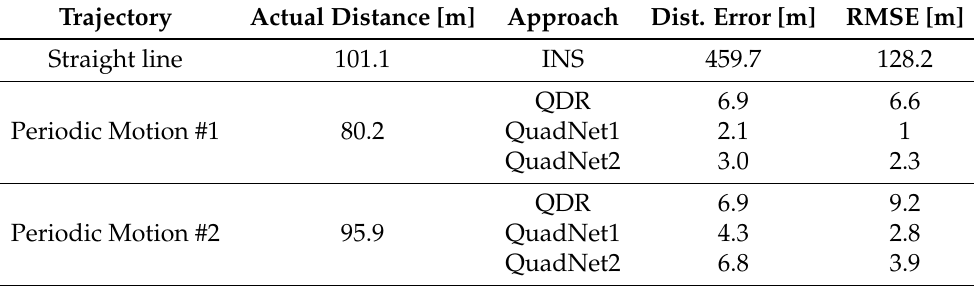
Table 2. INS, QDR, and QuadNet distance estimation errors for IMU #2.